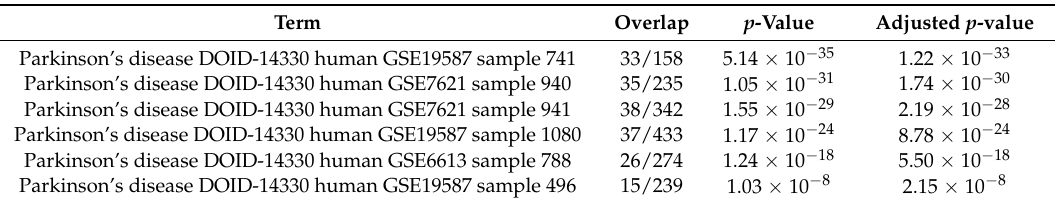
Table 3. Seven PD expression profiles in “Disease Perturbations from GEO up” where 244 gene symbols are enriched.